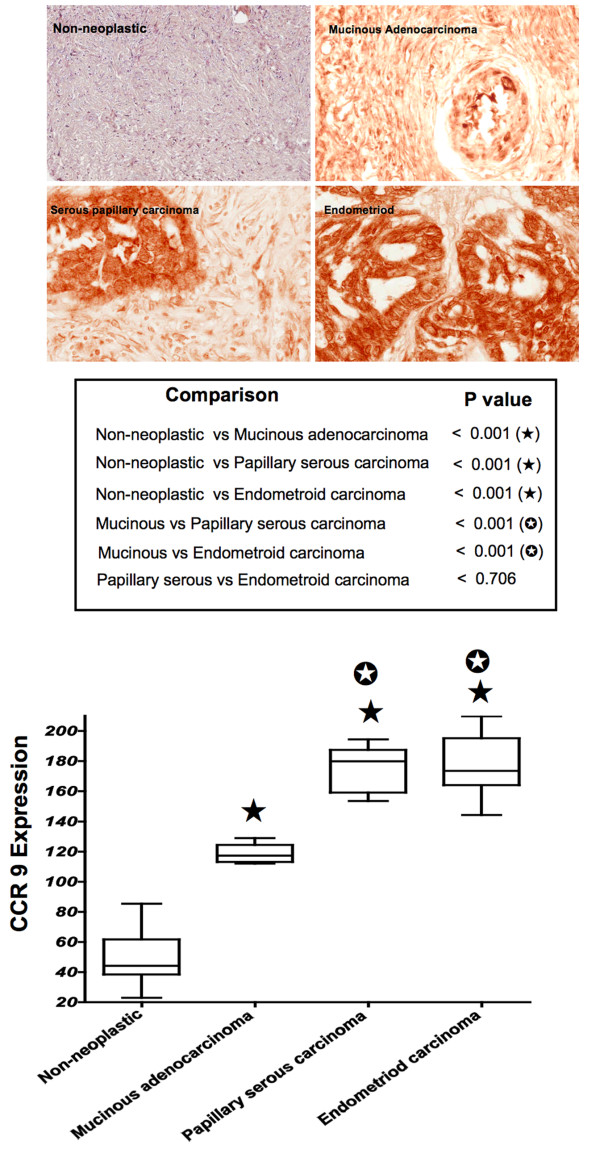
CCR9 expressed by ovarian cancer tissue. Ovarian cancer tissues from non- neoplastic (n = 8), mucinous adenocarcinoma (n = 5), serous papillary carcinoma (n = 10), and endometroid carcinoma (n = 11) were stained with isotype control or anti-CCR9 antibodies. Brown (DAB) color show CCR9 staining. An Aperio ScanScope CS system with a 40× objective captured digital images of each slide. Representative cases are indicated and immuno-intensities of CCR9 were quantified using image analysis Aperio ImageScope v.6.25 software. CCR9 expression by tissues were analyzed and presented by modified box plot. Lower, middle and upper lines, respectively, in the box represent the first quartile (Q1), Median (Q2) and third quartile (Q3). Upper (T) and lower (⊥) whiskers are represented by median ± 1.5 (Q3-Q1). Significant differences from non-neoplastic are indicated with a solid star whereas significant differences between mucinous adenocarcinoma and serous papillary as well as endometroid carcinomas are indicated with a white star in a black circle.